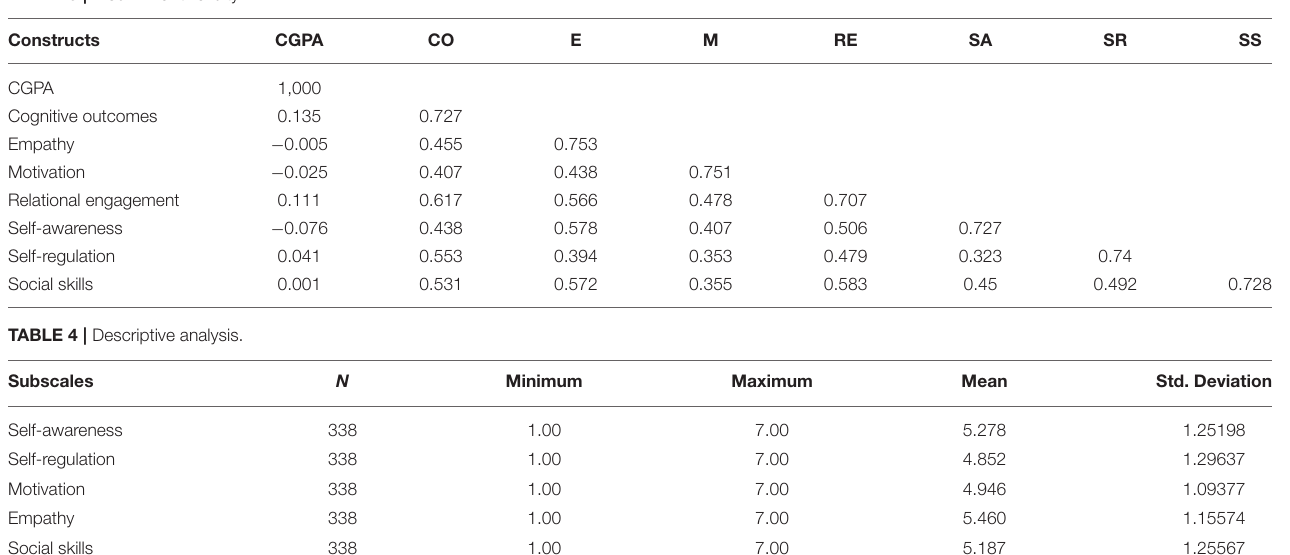
TABLE 3 | Discriminant validity.